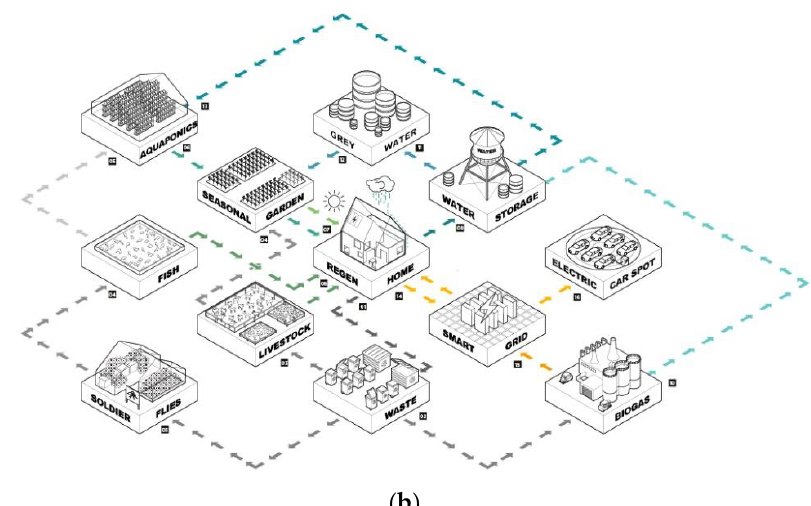
Figure 8. Regen Village inspired by natural closed-loop system: ( a ) Simulated model of Regen Village, Almere; ( b ) Regen system: exchange between waste–food–water–energy. Images ( a , b ): reprinted with permission from ref. [103]. Copyright 2022 © EFFEKT. Table 1. Summary of the case studies according to biomimetic design